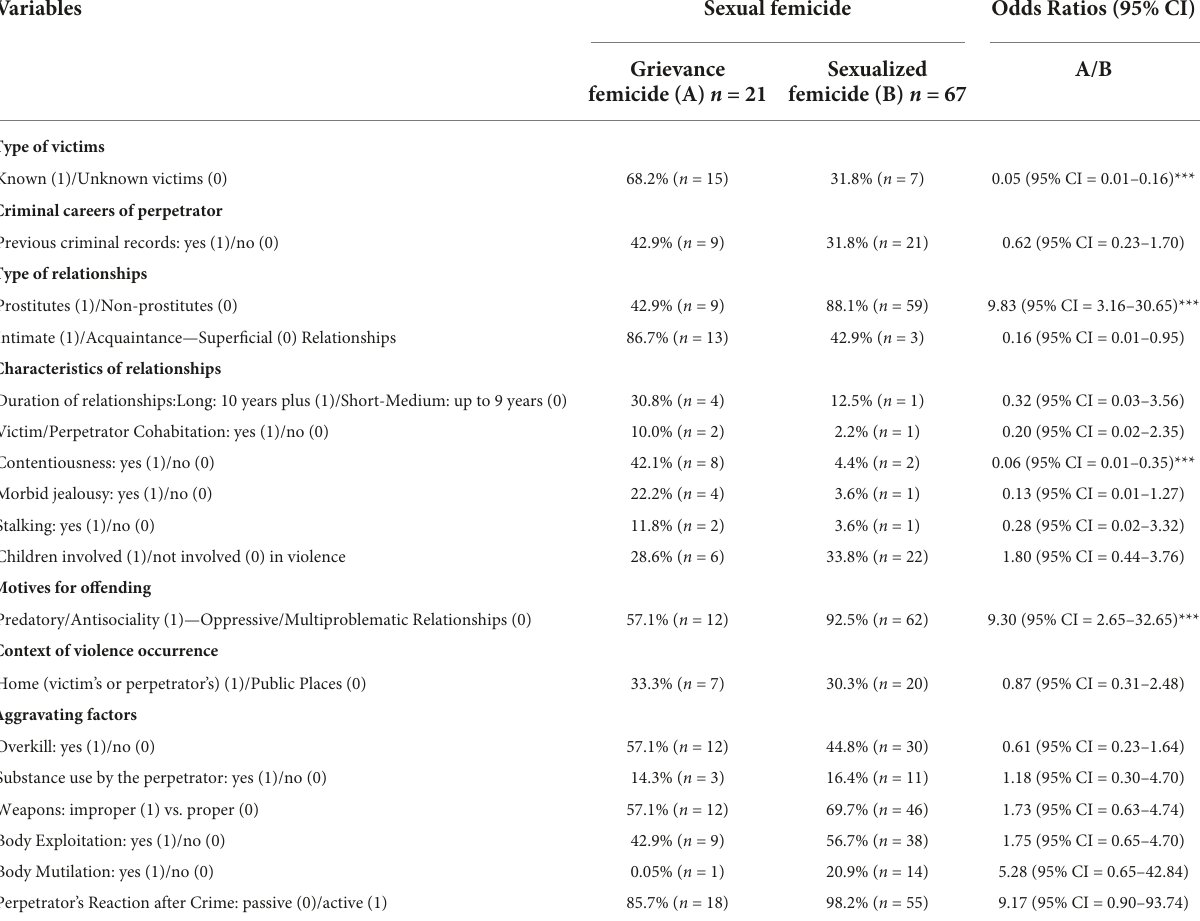
TABLE 4 Comparisons of grievance femicide versus sexualized femicide.